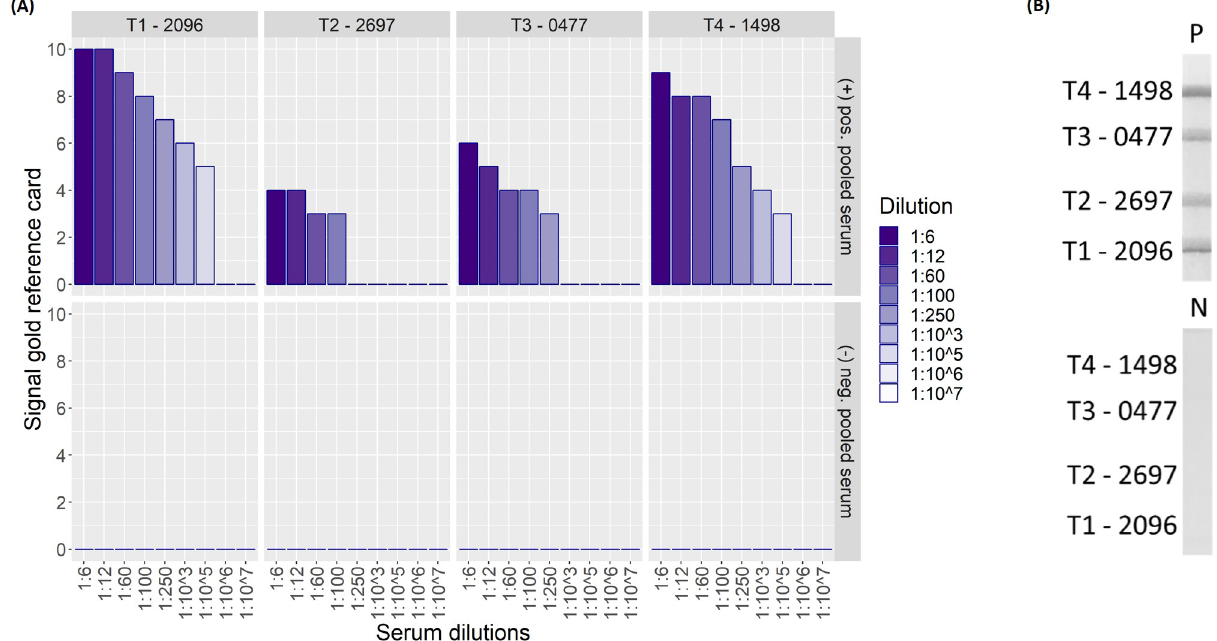
Fig 2. Comparison of Melioidosis DS signal intensities for pooled positive and negative sera over a serum dilution range from 1:6 to 1:10 7 . (A) Signal intensities for all four antigen bands (T1 to T4) are shown for pooled positive and negative serum respectively. The dipstick assay can easily discriminate between these samples up to a dilution of 1:100 for all spotted antigens (T1 to T4). (B) Exemplary dipstick of pooled positive (top) and negative (bottom) serum. A low intensity control line was present on both test strips, but it is not visible on the photographs.